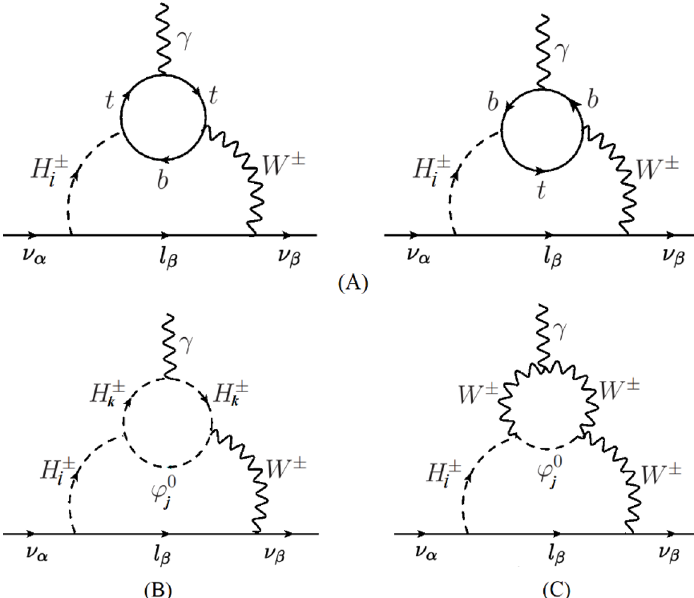
Figure 16 . Feynman diagrams for the neutrino transitional magnetic moment, via the quark Yukawa coupling and via the Higgs quartic coupling. We categorize three contributions like this: (A) q (cid:22) q(cid:13) vertex: the contribution from the two diagrams in the top panel, (B) H + contribution from the left (cid:12)gure in the bottom panel and (C) W + W (cid:0) (cid:13) vertex: contribution from the right (cid:12)gure in the bottom